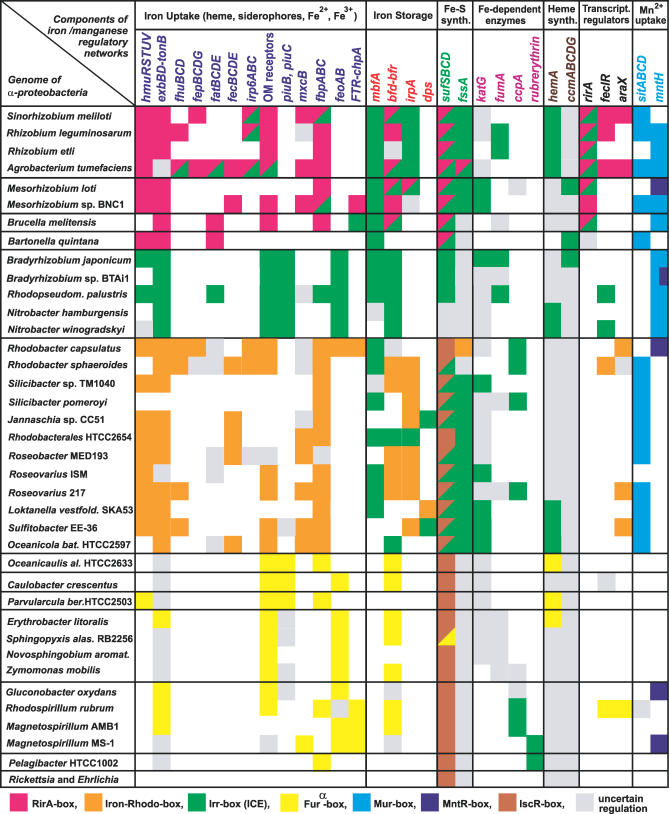
Occurrence of Candidate Regulatory Elements and Genes Involved in the Iron and Manganese Homeostasis in α-ProteobacteriaOnly conserved members of the predicted Fe/Mn regulons are shown. Genes are arranged by their functional role. Genomes are arranged by taxonomic lineages. When the gene is present in the genome, the background colors denote the presence of the specific recognition motif in its upstream region. If the gene is preceded by two different regulatory motifs, it is shown by a diagonally separated bicolor square. Differential regulation of two mntH paralogs in Bradyrhizobium sp. BTAi1 by Fur/Mur and MntR regulons is shown by vertically separated bicolor square. Genes without any candidate iron or manganese regulatory motifs described in this study are indicated by grey background color. Empty crossings denote the absence of an orthologous gene in the genome.